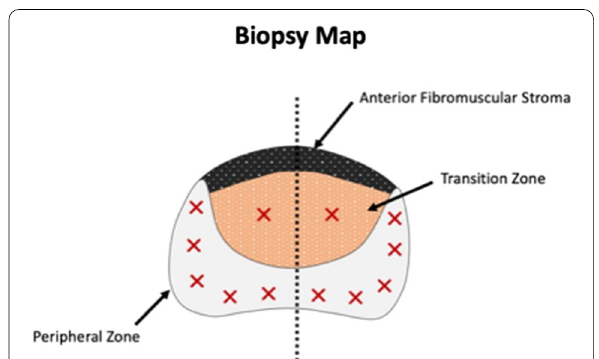
Fig. 13 Standardised sampling biopsy